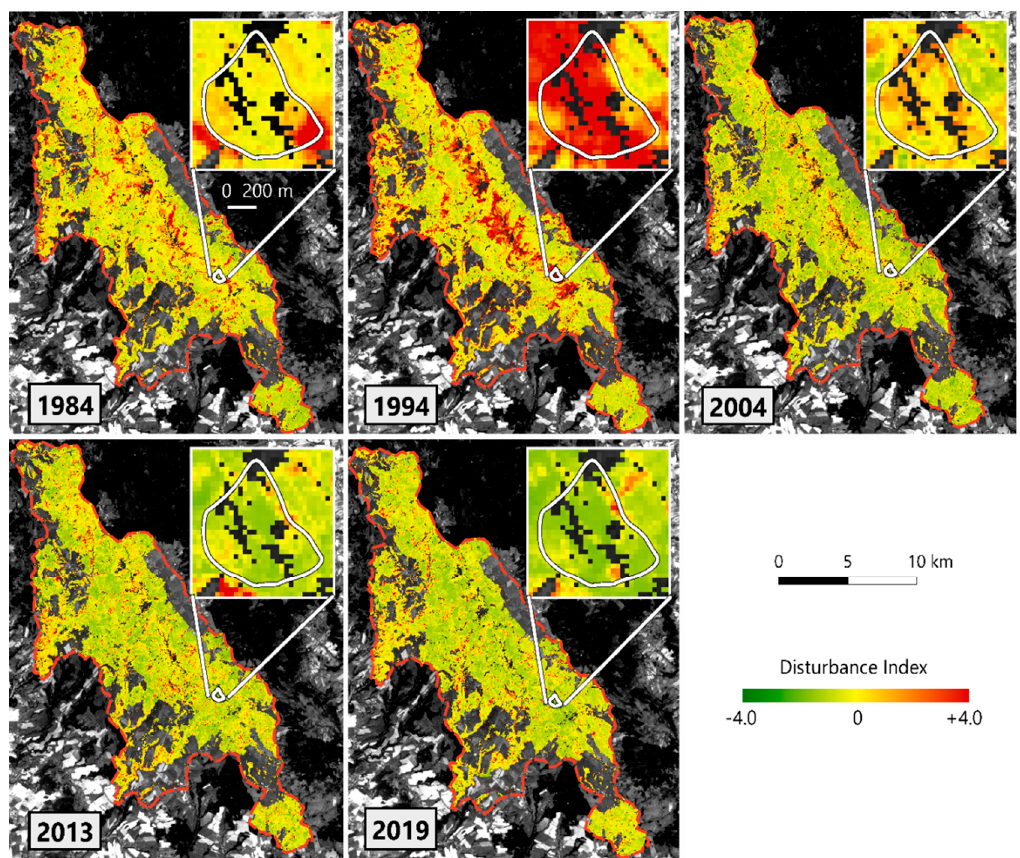
Figure 7. Decennial changes in the Landsat-derived disturbance index computed for the Eagle Mountains protected landscape area (protected since 1969), with detailed insight into the UDL catchment.